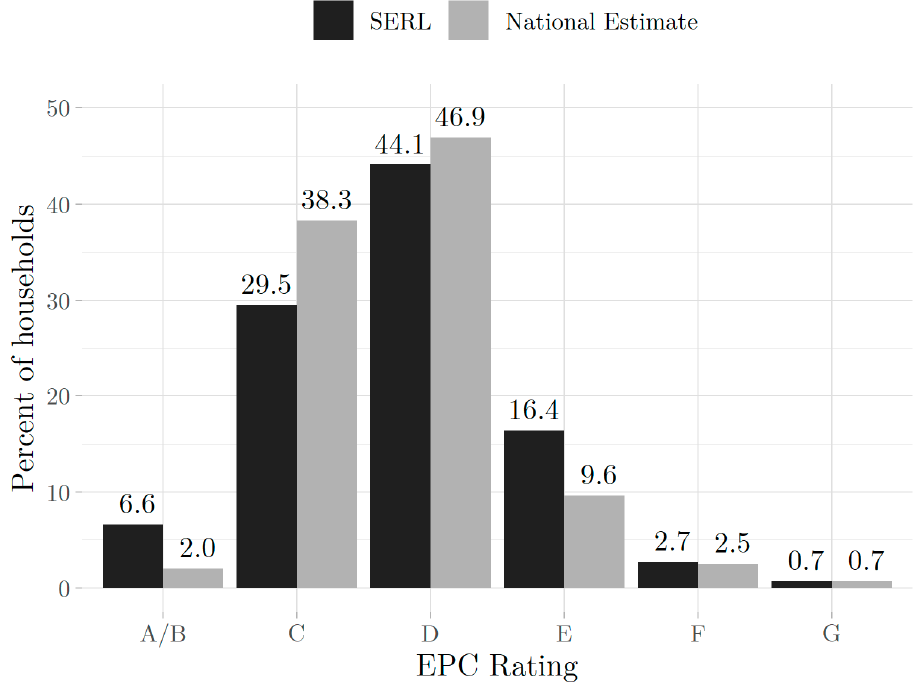
Figure 19. Percentage of dwellings in the SERL Observatory sample with each EPC rating (in England and Wales) compared to an estimate for England (EHS). Note that EPC ratings A and B have been merged as fewer than 10 households have EPC rating A.